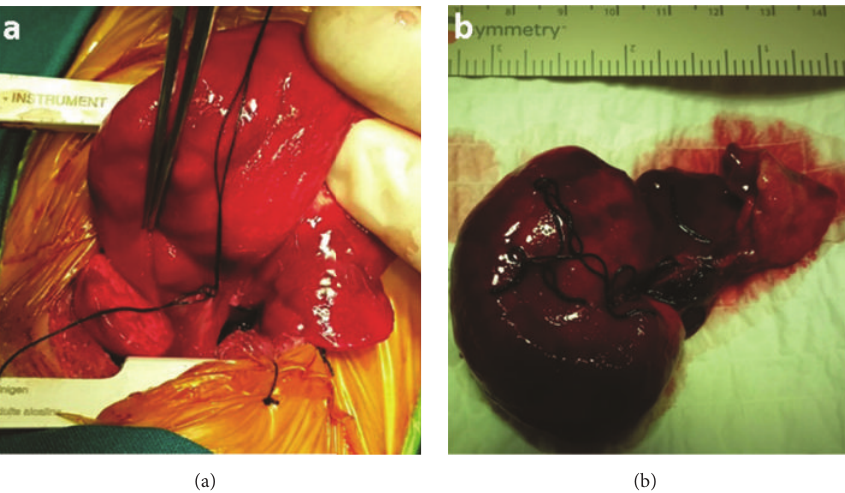
Figure 2: Intraoperative photos showing the macroscopic appearance of the hyperexpanded left upper